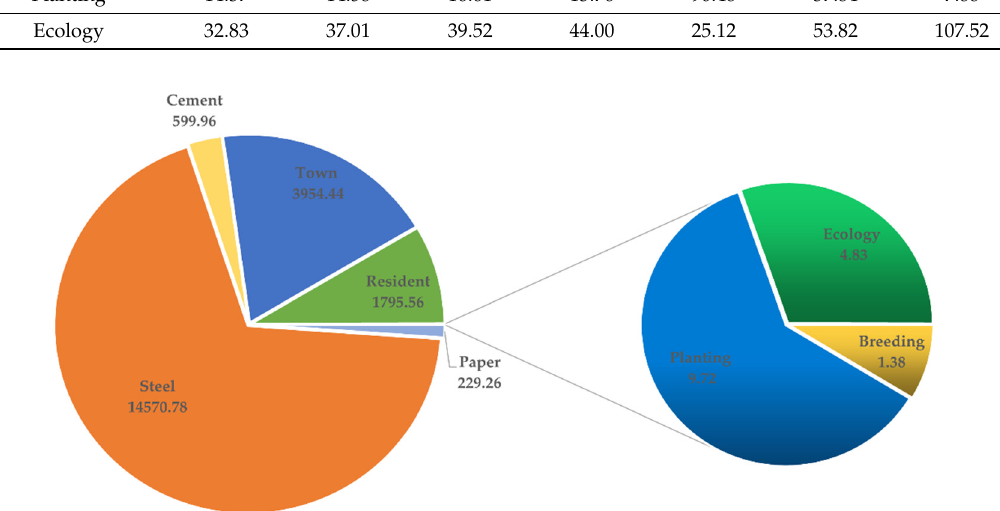
Figure 2. Adjustment of water resources utilization of different water sectors in Shanghang County in the first stage (×10 4 t). (Where the Thermal power industry is not the main industry in Shanghang County, so the thermal power industry is not considered when allocating water resources, value of 0.). The upper limit sub-model was used for calculating the optimal solution of water Table 1. Optimized allocation of water resources utilization of different water consumption sectors resources allocation in the first stage. Since five different hydrological scenarios were set in each administrative unit in the upper and lower reaches of Tingjiang River based on the IFTS in this work, and the upper limit of water resources development and utilization and of model in the first stage (× 10 4 t). the total water utilization were set as fuzzy variables, the model was further optimized to obtain a more scientific and stable solution. Based on the IFTS model, the DIS ± caused by the water quantity failing to meet the goal of the first stage was solved, i.e., the added value of water consumption caused by the failure of the optimal water quantity in the first stage, as shown in Table